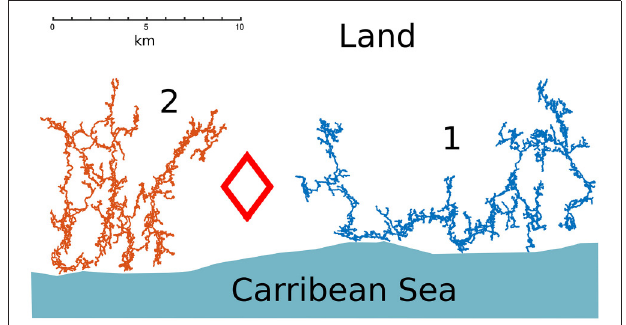
FIGURE 1 | Cave divers’ maps of (1) the Sac Actun system and (2) Ox Bel Ha. The diamond symbol represents the location of the town of Tulum and the coastline is